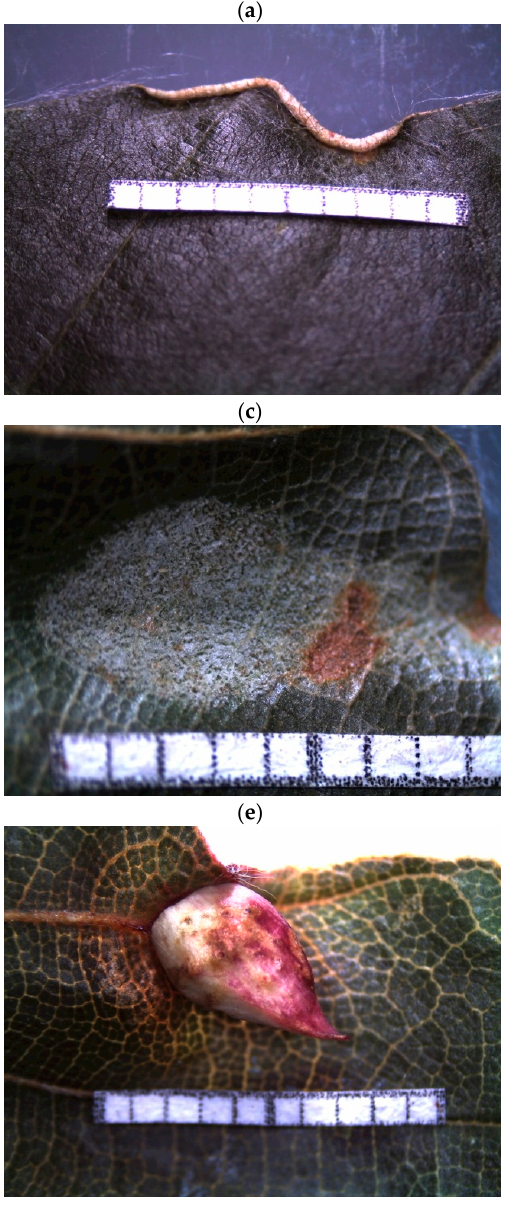
Figure A3. Feeding traces (Recognizable Taxonomic Units) of gall-inducers (endophagous feeding guild) on Fagus sylvatica leaves. ( a ) Rolled-up leaf edge (probably Acalitus stenaspis , ADS); ( b ) haired gall on leaf veins (probably Aceria nervisequa , ADS); ( c ) pannose spot between veins (probably Aceria nervisequa faginea , ABS); ( d ) haired brownish gall (probably Hartigiola annulipes , ADS); ( e ) ovate, acuminated gall (probably Mikiola fagi , ADS); ( f ) pleated gall (probably Phegomyia fagicola , ADS). Images were taken with an integrated digital camera of a stereo microscope (LEICA EZ4 D, Wetzlar, Germany). Little square equals 1×1 mm, ADS = adaxial side, ABS = abaxial side.